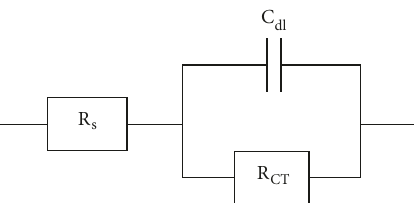
Figure 5: Equivalent circuit model to fit the metal/acid interface containing different concentrations of the synthesized corrosion inhibitors.